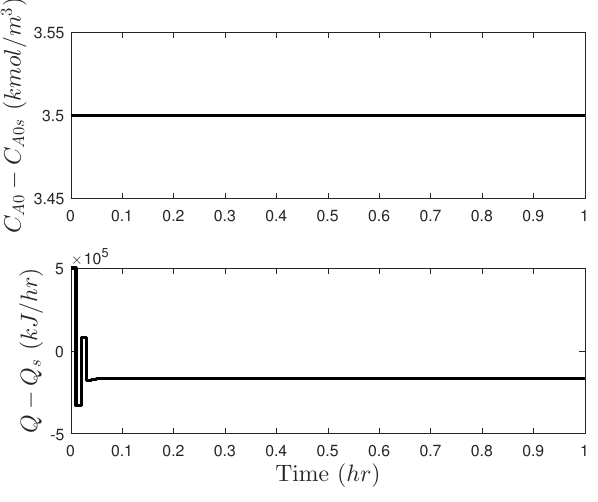
Figure 5. Input trajectories under the single LMPC for the CSTR of Equations (46) and